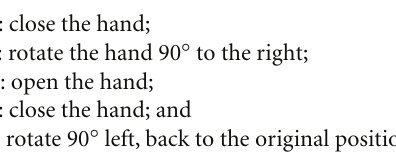
FIGURE 7 | Prosthetic hand with four mounted LEDs (A), examples of respiratory signals (Resp), heart beat-to-beat intervals (RRI) measured in seconds and fi rst derivative of RRI (dRRI) during intentional (B) and non-intentional control (C). Two motion sequences (O, R, L, C) and the threshold are indicated. Modifi ed from Scherer et al.